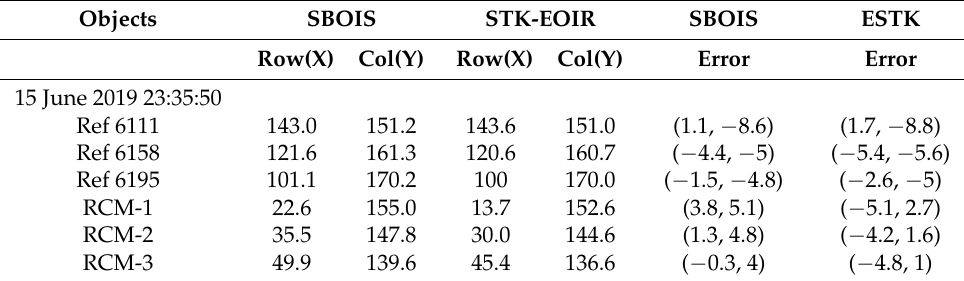
Table 2. Summary of Simulator